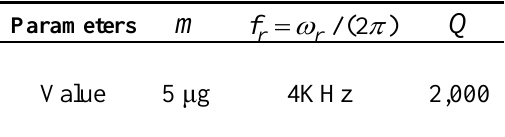
Table 1. Example parameters for an MVG.